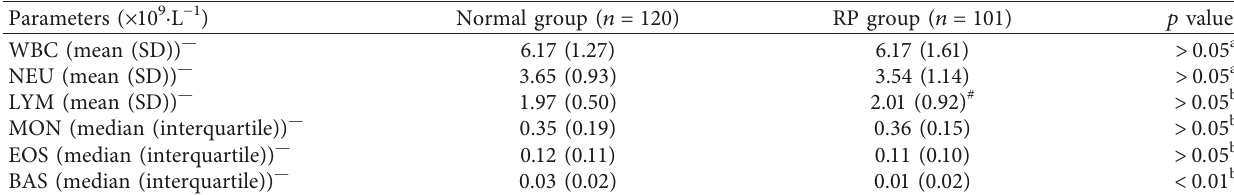
Figure 1: Comparison of RBC indicators between the normal and RP group. All data were in accordance with the normal distribution, and two independent samples t -tests were performed for comparison. p < 0 . 05 was considered statistically significant; ∗∗ p < 0 . 01 was considered statistically very significant. Table 2: Comparison of WBC indicators between the normal and RP